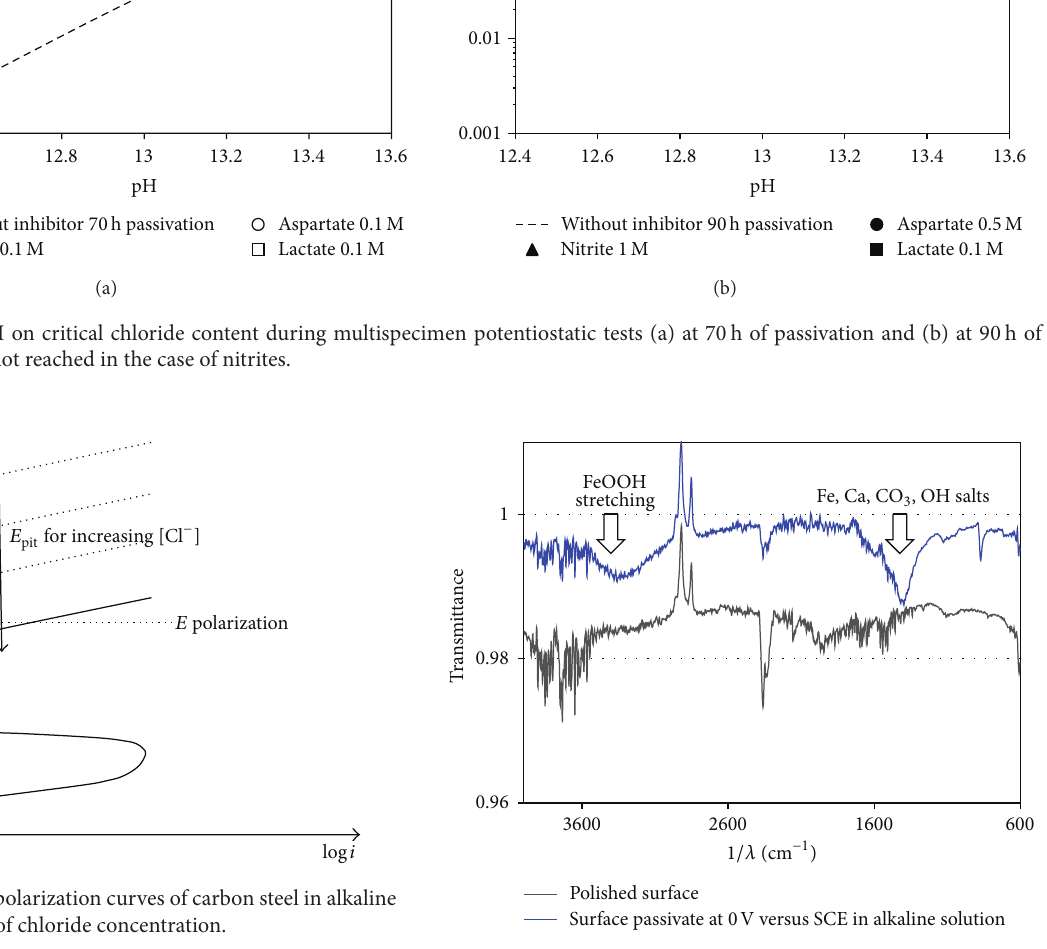
Figure 11: FTIR spectra of a polished specimen and a specimen passivated in solution at pH 13.5 and 0 V versus